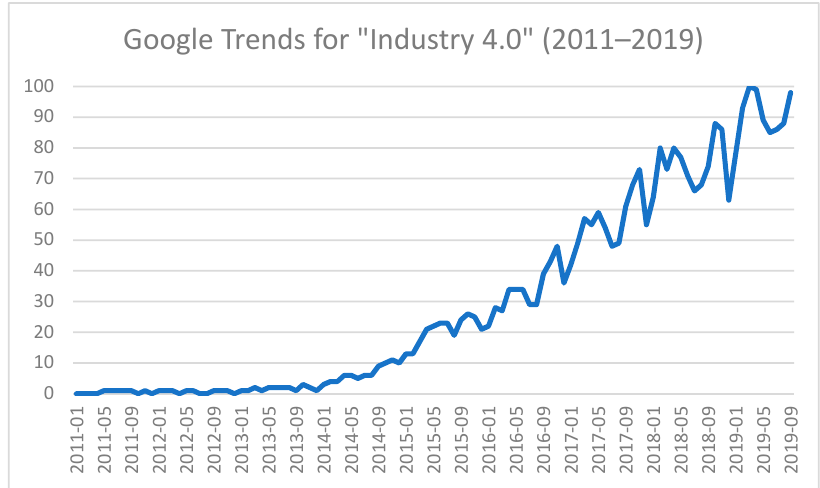
Figure 2. Google Trends for “Industry 4.0” (2011 – 2019) (Data Source: https://trends.google.com; Retrieved 9 September 2019 and displayed using Microsoft Excel).